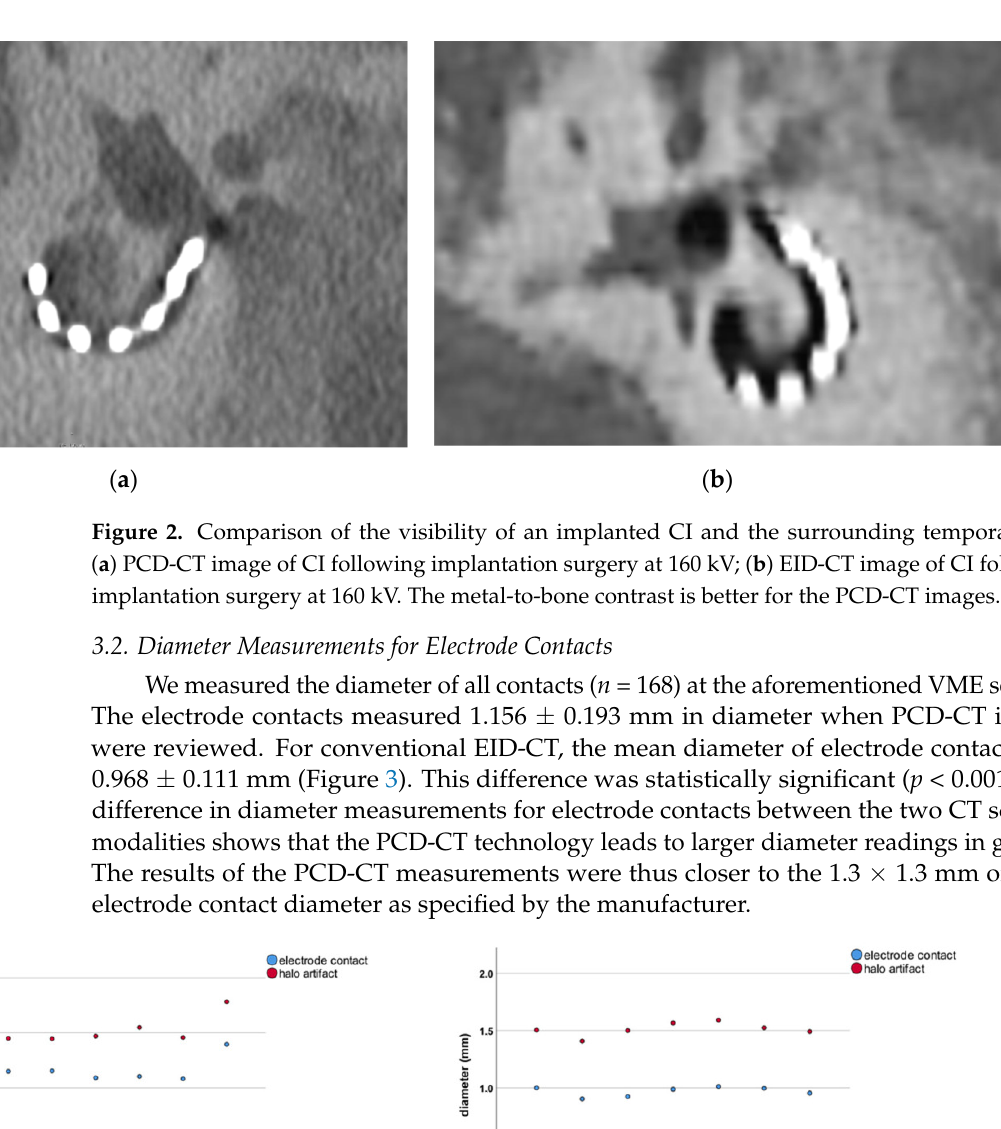
Figure 2. Comparison of the visibility of an implanted CI and the surrounding temporal bone. ( a ) PCD-CT image of CI following implantation surgery at 160 kV; ( b ) EID-CT image of CI following implantation surgery at 160 kV. The metal-to-bone contrast is better for the PCD-CT images.